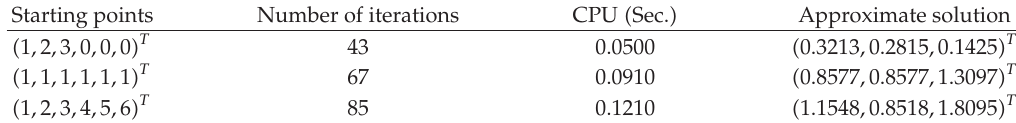
Table 1: Results for Example 6.1 using the HRP method in (cid:5) 2 (cid:6) .